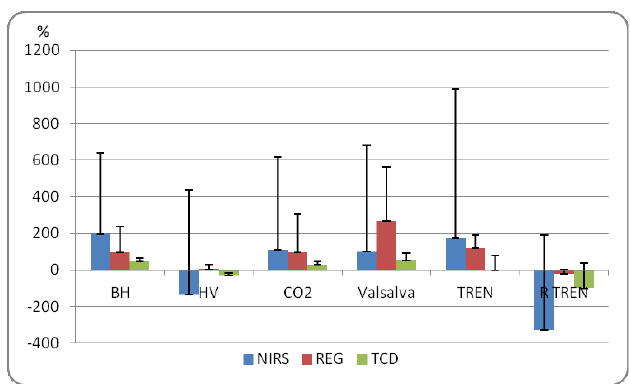
Fig. 5. NIRS, REG and TCD during tests. Data are as percent of baseline (mean + SD). Tests are as BH: breath holding;